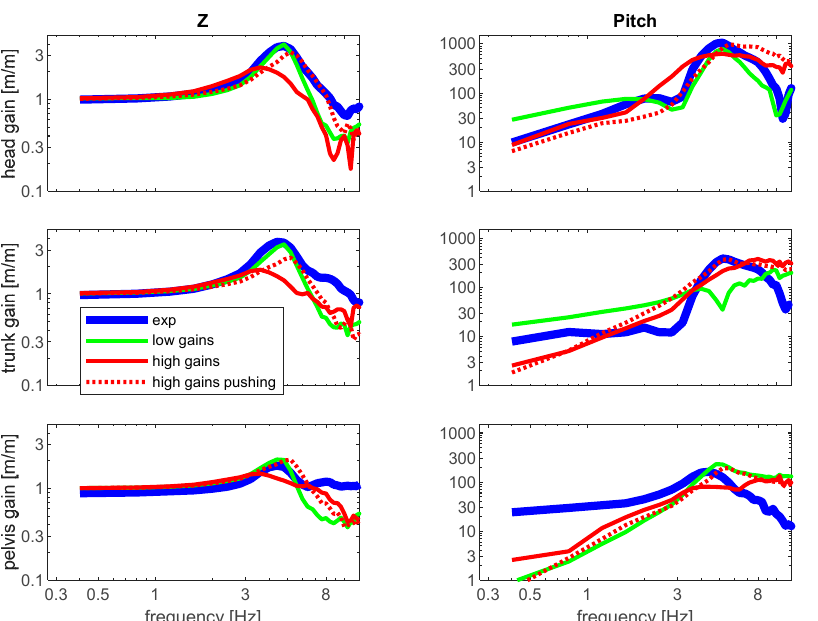
Figure 5. Lateral vibration validation. Model prediction of head ( upper ), trunk ( middle ) and pelvis ( lower ) in translation ( left ) and roll and yaw rotation ( middle and right ). Blue line: experimental; solid green line: best model with low postural gains; red solid line: high gains fitted towards the slalom but no pushing; red dotted line: high gains and with hips and knees pushing the body into the seat back.